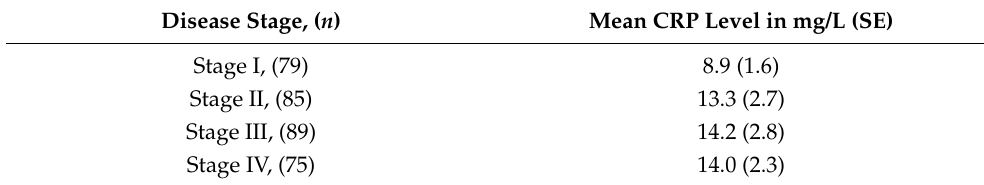
Table A3. CRP levels in patients within the same disease stage ( n =